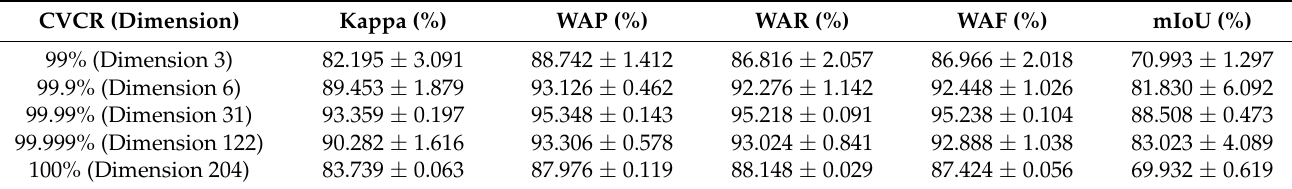
Table 2. Comparison of segmentation performance of the model with different